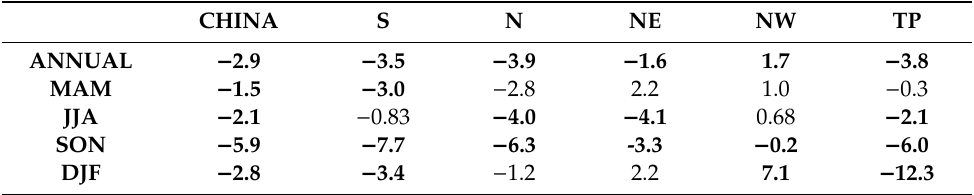
Table 2. Decadal trend of annual and seasonal averaged precipitation days in China and its five classified regions (bold values indicate that the changes passed the 95% significance test) (unit: % / 10 years).